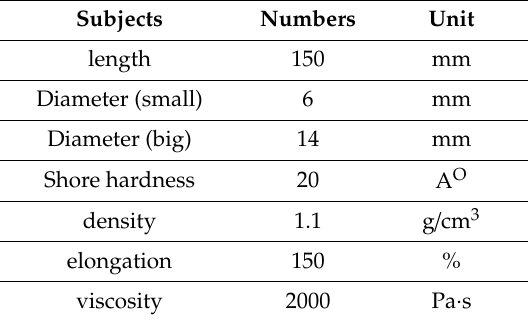
Table 1. Parameters of soft